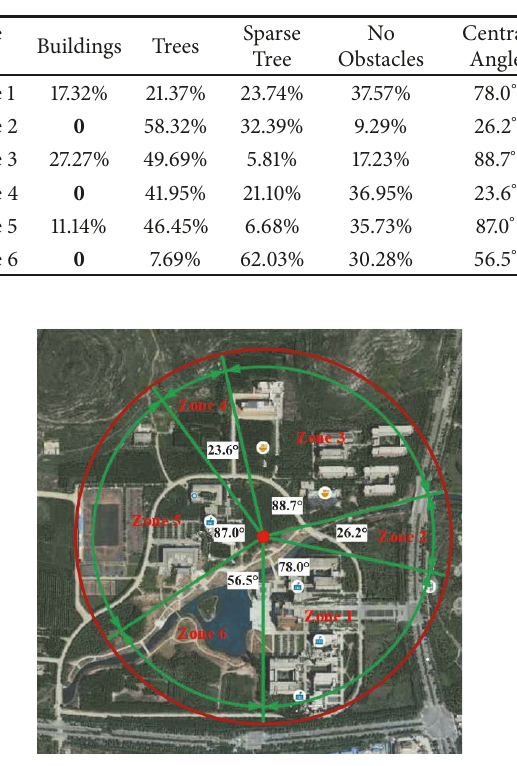
Table 2: Percentage of different types of areas and central angles.